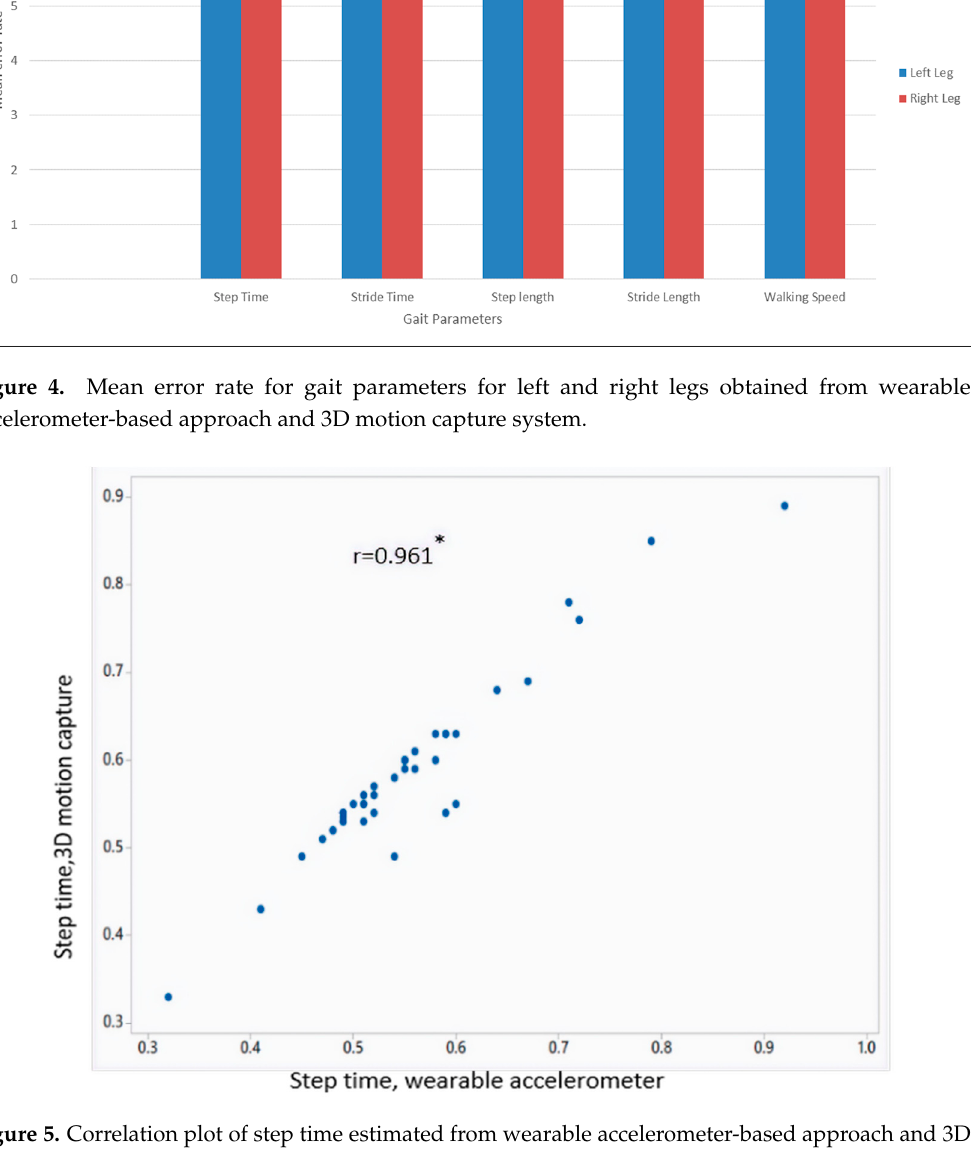
Figure 5. Correlation plot of step time estimated from wearable accelerometer-based approach and 3D motion capture system (* p < 0.01).